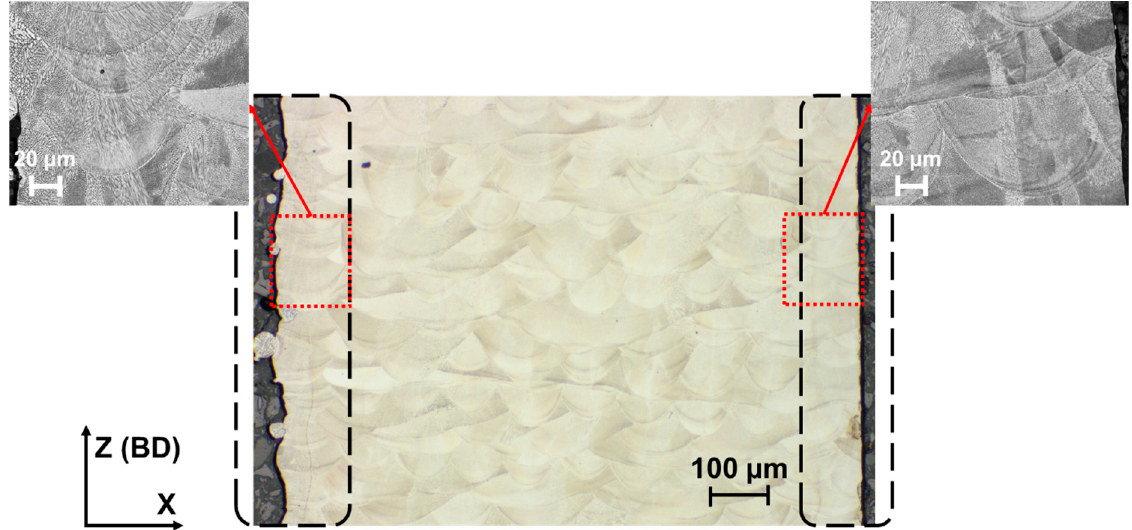
Figure 8. Low magnification image on an etched sample (10×) showing as-printed surface on left side and turned surface on right side. Inset image on left side shows a magnified image (50×) of the surface showing stacking of melt pools coming from contour scanning, which is removed after turning (as seen in inset image on right).